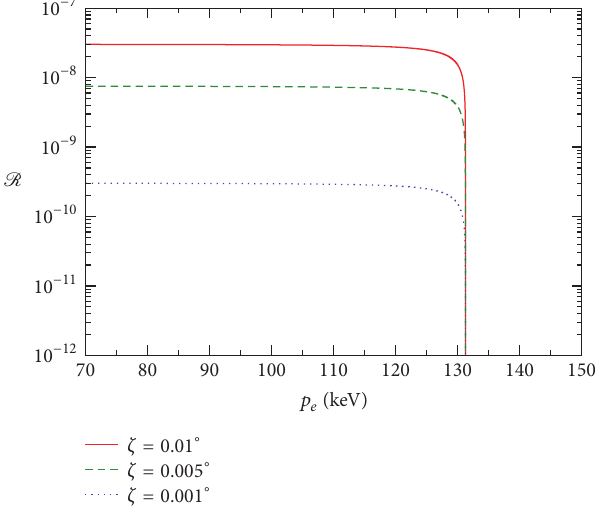
Figure 4: Ratio R , defined in (25), for the Tritium beta decay, as a function of the electron momentum for a heavy neutrino mass 𝑚 ℎ = 2 keV and different values of the mixing angle: 𝜁 = 0.01 ∘ (solid line), 0.005 ∘ (dashed line), and 0.001 ∘ (dotted